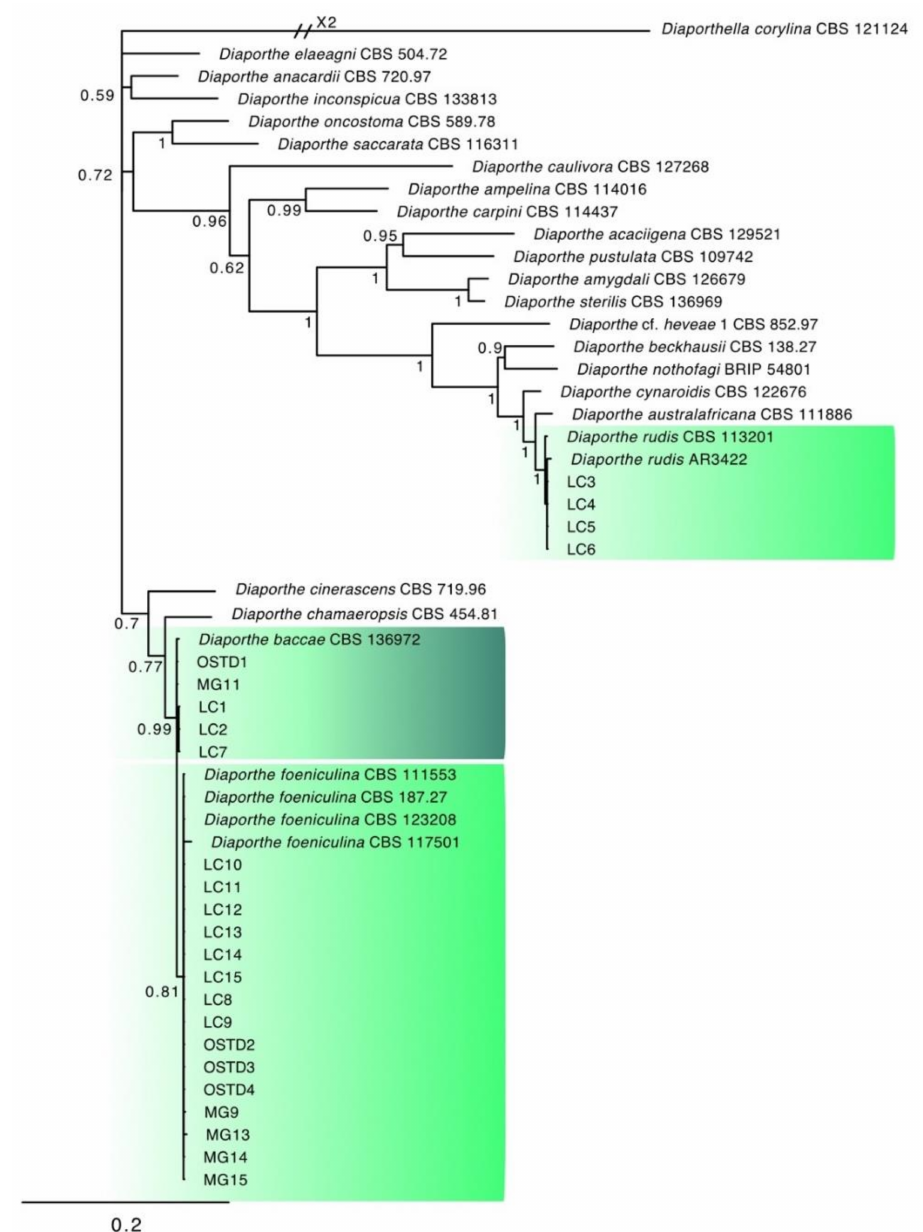
Figure 4. Consensus phylogram of 3582 trees resulting from a Bayesian analysis of the combined ITS, tef1 , and tub2 sequence of Diaporthe species. The tree was rooted to Diaporthella corylina (CBS121124). Bayesian posterior probability values are indicated at the nodes. The clusters containing the isolates obtained in this study are highlighted in